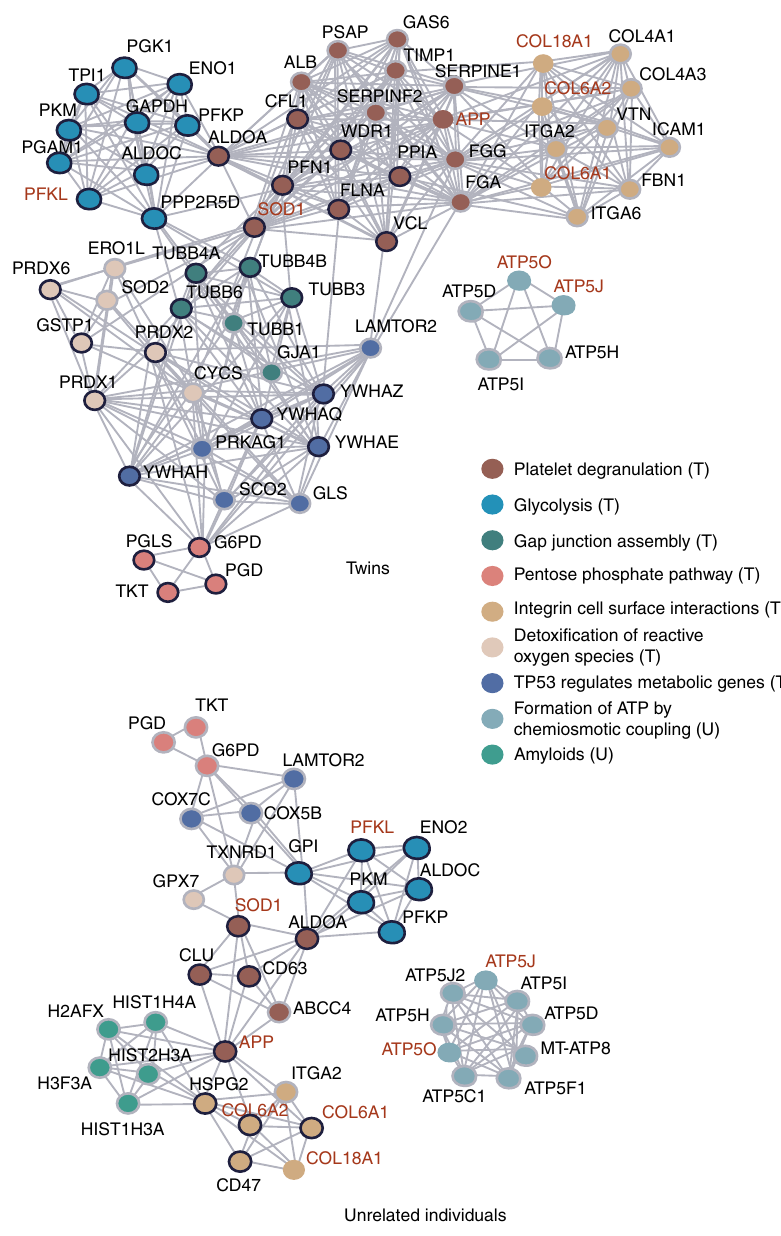
Fig. 4 Signi fi cantly regulated proteins and their network associated to T21. Proteins in the reactome pathways that were found to be signi fi cantly enriched ( P < 0.01, see Methods for details) are represented as a network graph, where edges indicate functional connections, i.e., links between proteins in same reactome pathways. Nodes represent individual proteins and these are colored according to a dominant reactome pathway annotation. If the protein is upregulated, its node border is black, if it is downregulated it is light gray. Names of the proteins encoded by the genes on the chromosome 21 are shown